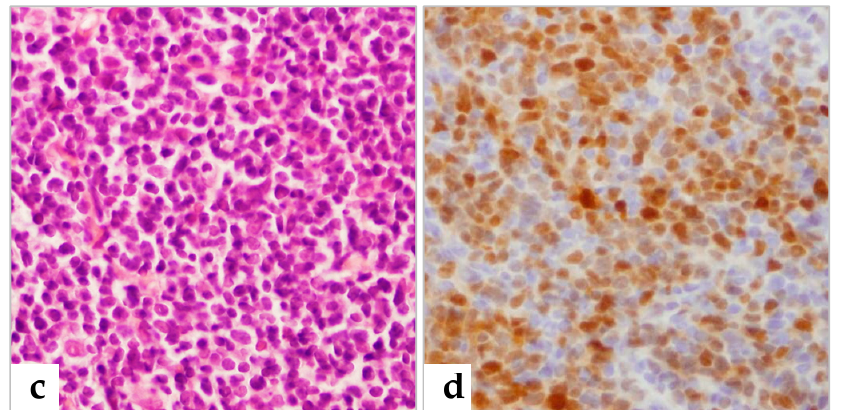
Figure 3. A patient diagnosed with reactive hyperplasia by FNAC was histologically diagnosed with